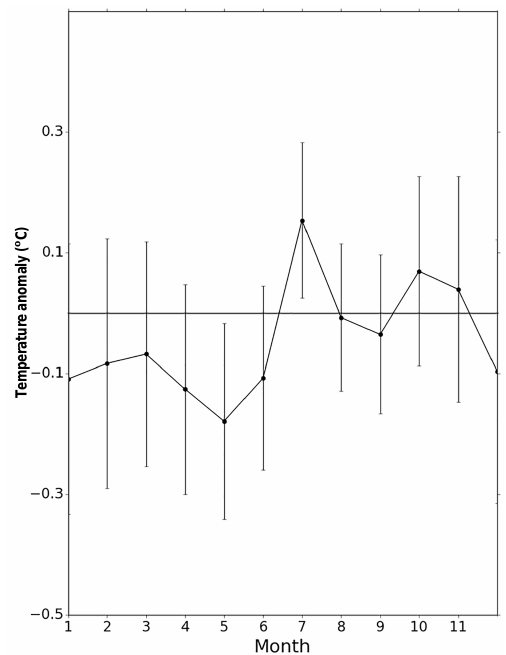
Figure 11. Indian temperature seasonality; KK10 − control surface temperature anomalies for the late pre-industrial (1850CE) simula- tion; the vertical bars indicate the normal range of variability which is considered to be within 2 standard deviations of the